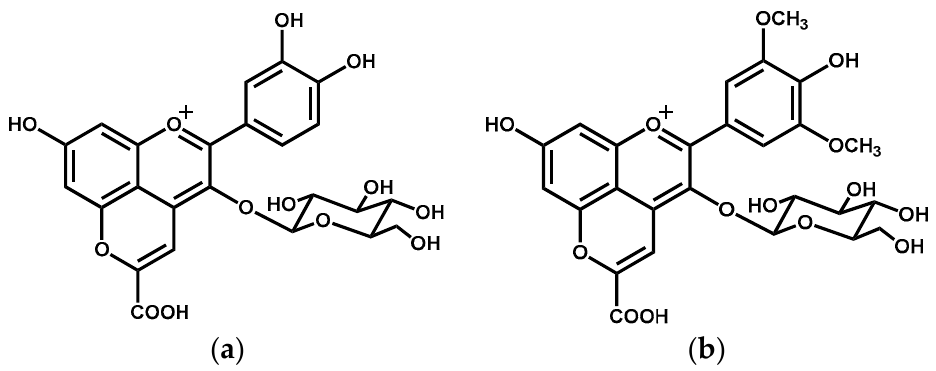
Figure 10. Chemical structures of ( a ) carboxypyranocyanidin-3- O -glucoside (carboxypyCy-3-glc) and ( b ) carboxypyranomalvidin-3- O -glucoside (carboxypyMv-3-glc), the main pyranoanthocyanin present in the carboxypyrano-ant extract.